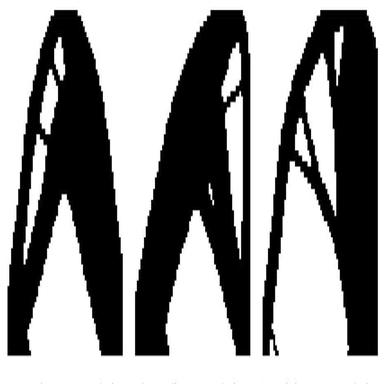
Three designs chosen from the scalar maximum-stress values.